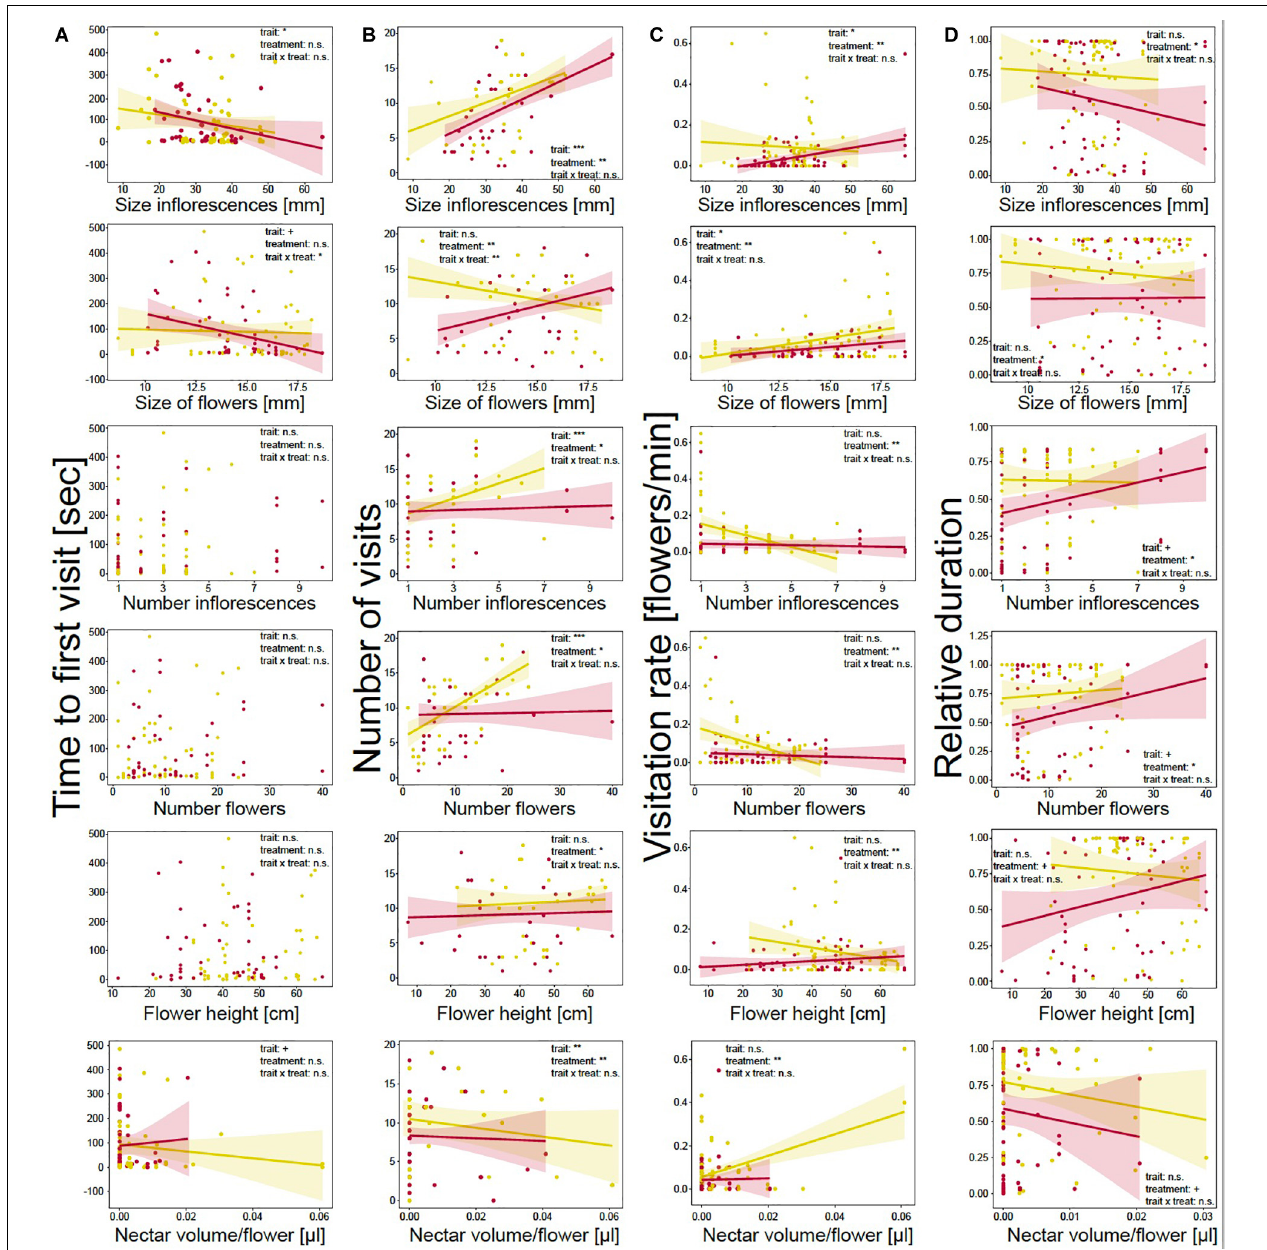
FIGURE 2 | Behavior of bumblebees in correlation with measured morphological traits and drought treatment. (A) Time to first plant visit [sec] (approach or landing); (B) number of plant visits (approaches plus landings); (C) visitation rate of flowers [min]; and (D) relative duration of landings. Plant trait values are mean values. Each dot represents one event on a plant. Colored lines show trend lines for significant correlations of behavior and plant trait; colored areas show confidence interval. Correlations were measured using linear mixed-effect models. Significance levels are given as asterisks: *** p < 0.001; ** p < 0.01;* p < 0.05; + p < 0.10; and n.s.,